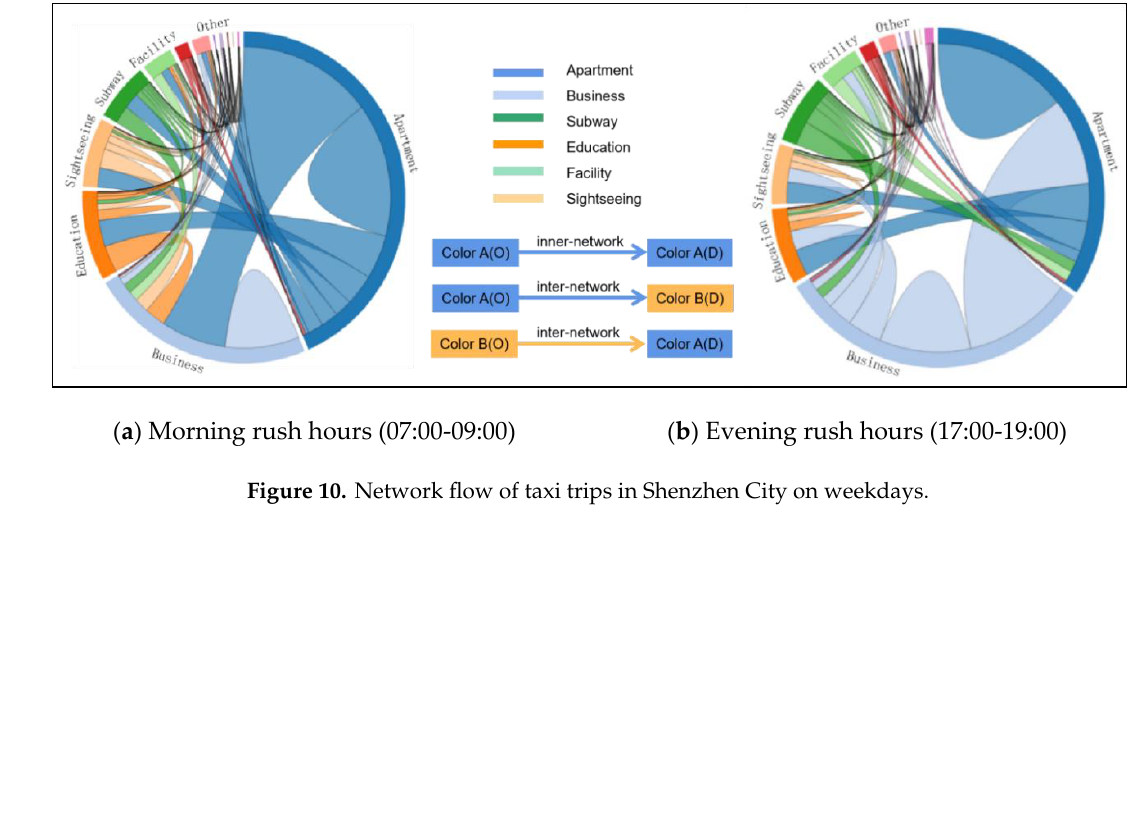
Figure 11. Network flow of taxi OD trips in Shenzhen City on weekends. 6. Conclusions and Future Work The better understanding of taxi trip patterns is important for transport planning optimization. First, with the country’s vigorous promotion of new energy fields and a series of policy support, there are more and more new energy vehicles. It is very important to choose the appropriate sites for charging stations. The spatial distribution of OD densities based on imNKDE could help us know the main area of taxi trip, which could provide reference for the site selection. Meanwhile, the knowledge of ODs densities could guide the setting of stops for taxis. The proper setting of taxi stops can effectively reduce traffic jams and enhance the city image. Second, due to some reasons, such as the traffic jams, road maintenance and others, there are many taxi trips do not follow the shortest path rule. Therefore, with the relationship analysis between taxi trip and shortest path, the decision makers could know the possible deficiencies in the current transportation network, and design new strategies to improve the traffic network and promote the development of traffic. Last but not least, the network flow pattern of taxi trip could reflect the relationship between taxi trip and land-use, it can provide a guidance for traffic planning in other cities.